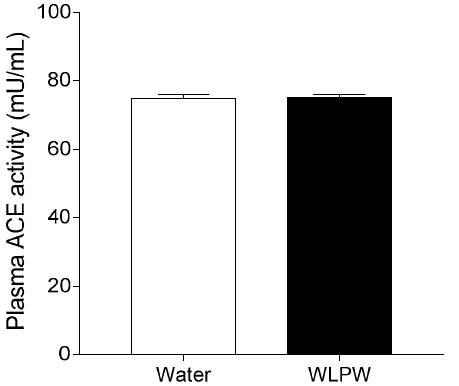
Figure 5. Plasma angiotensin-converting enzyme (ACE) activity in spontaneously hypertensive rats 6 h after administration of 125 mg/kg bw dried wine lees powder (WLPW) or water. Data are expressed as mean ( n = 6) ± SEM. No significant differences ( p < 0.05) were found between both groups (Student’s t-test).